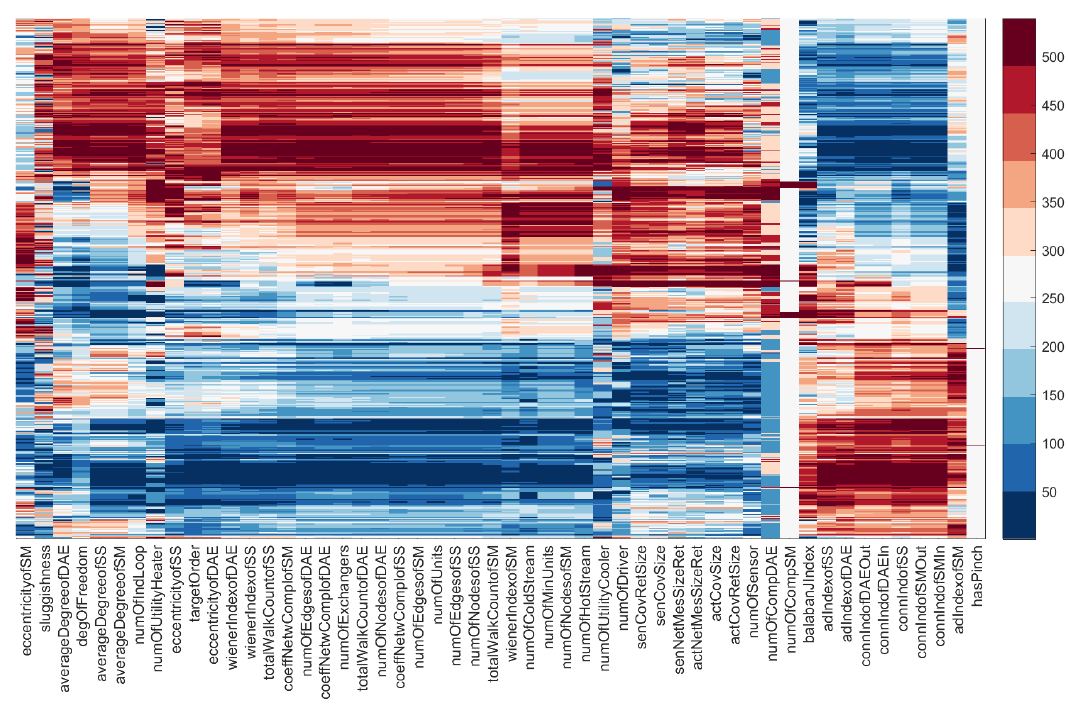
Figure 9. Similarity-based ordering of the 539 HENs (rows) and developed measures (columns). The networks are ranked according to each measure, the similarities were calculated by Spearman’s rank correlation and the colours of the map represent the rank